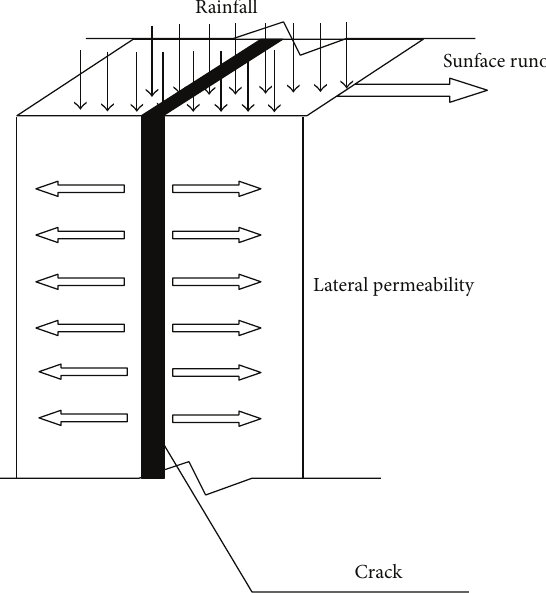
Figure 3: Rainfall infiltration model of soil with